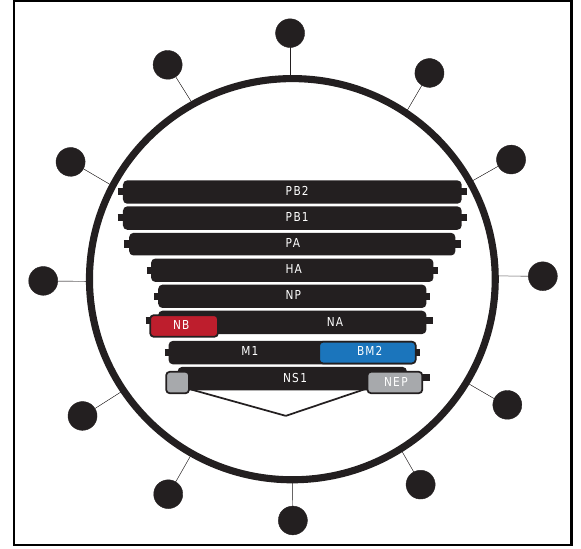
Figure 1. Schematic illustrating unique influenza B virus proteins. The RNA genome of the segmented influenza B virus (not to scale) with the unique gene products (relative to other influenza viruses) shown in color. Abbreviations: PB2 — polymerase basic protein 2, PB1 — polymerase basic protein 1, PA — polymerase acidic protein, HA — hemagglutinin, NP — nucleoprotein, NB — glycoprotein NB, NA — neuraminidase, M1 — matrix protein, BM2 — BM2 protein, NS1 — non-structural protein 1,